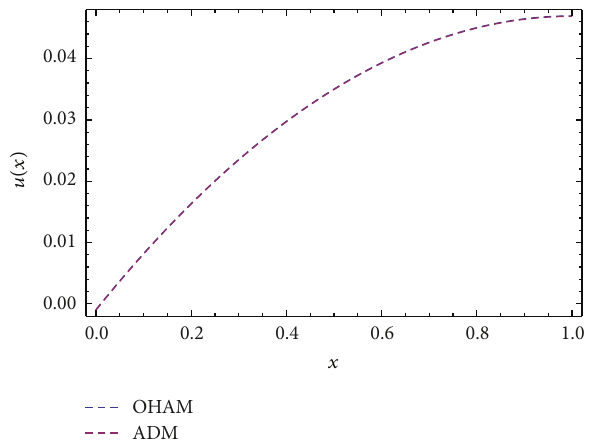
Figure 4: Comparison of ADM and OHAM methods for drainage velocity profile is shown for the given parameters and auxiliary constants. 𝑚 = 0.1 , 𝑀 = 0.1 , 𝛽 = 0.3 , Λ = 0.01 , 𝛼 = 0.1 , = −0.93798569 , and 𝐶 = −0.000741729 . 𝐶 1 2